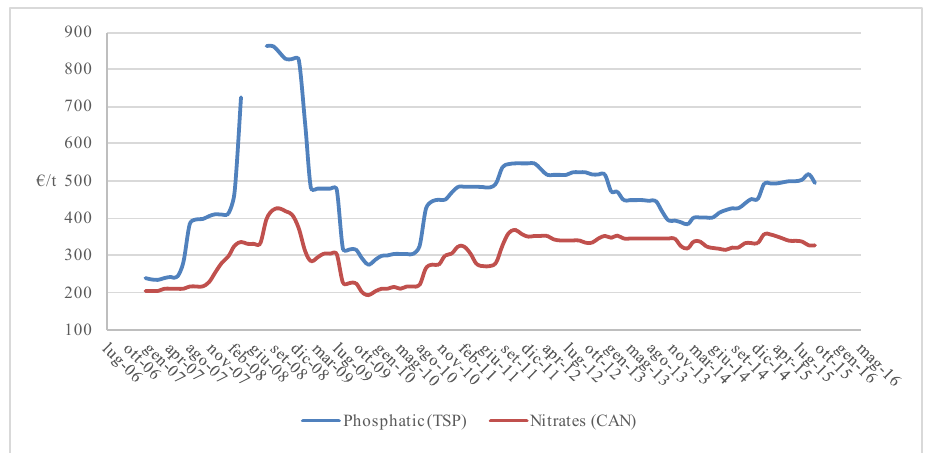
Figure 2. Evolution of N and P chemical fertilizer prices in the Emilia-Romagna